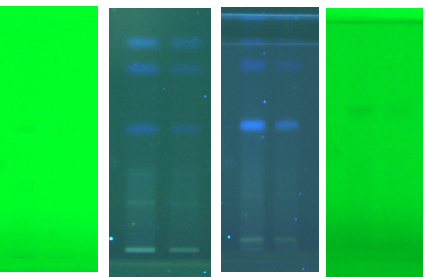
Figure 6 . (Plate no 6) HPTLC of